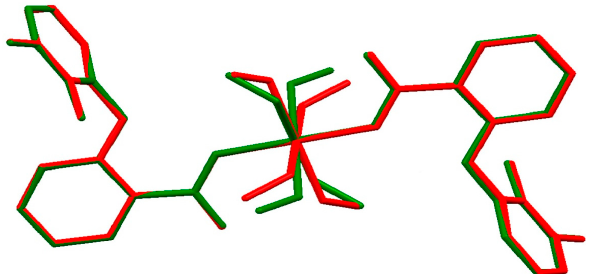
Figure 2. Molecular structures of 3 (a) and 4 (b). Hydrogen atoms are omitted for clarity. Displacement ellipsoids are drawn at the 50% probability level. Only asymmetric units are labeled.